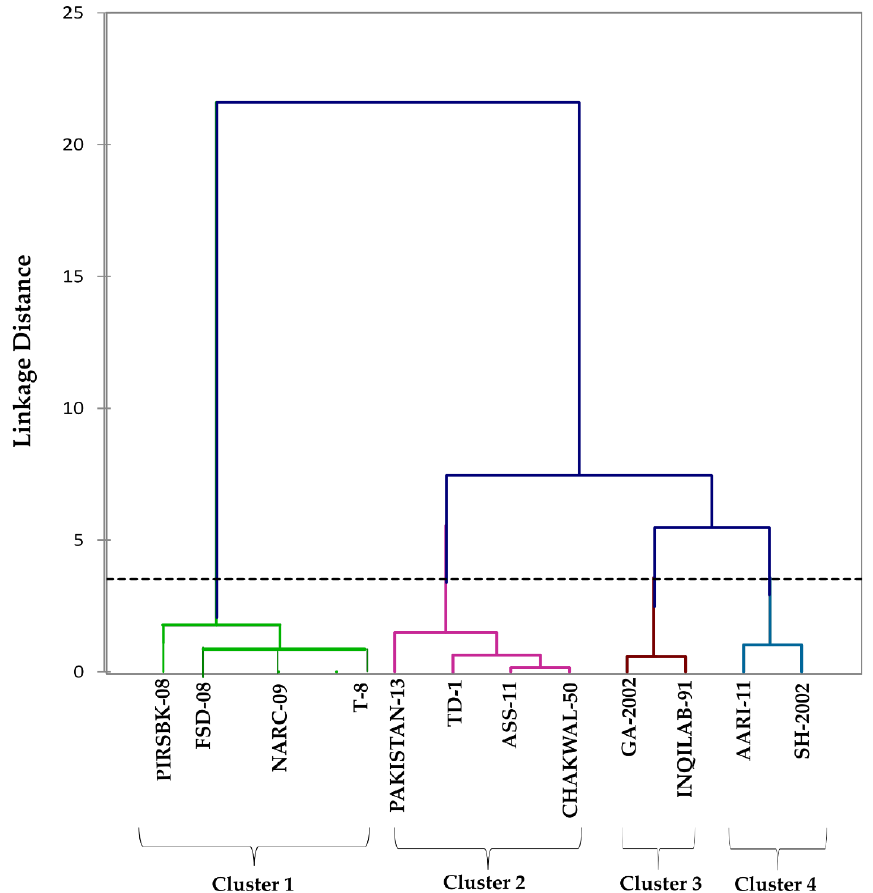
Figure 2. Dendrogram analysis showing four clusters, i.e., cluster 1 (N-use efficient), cluster 2 (moderately N-use efficient), cluster 3 (moderately N-use inefficient) and cluster 4 (N-use inefficient).